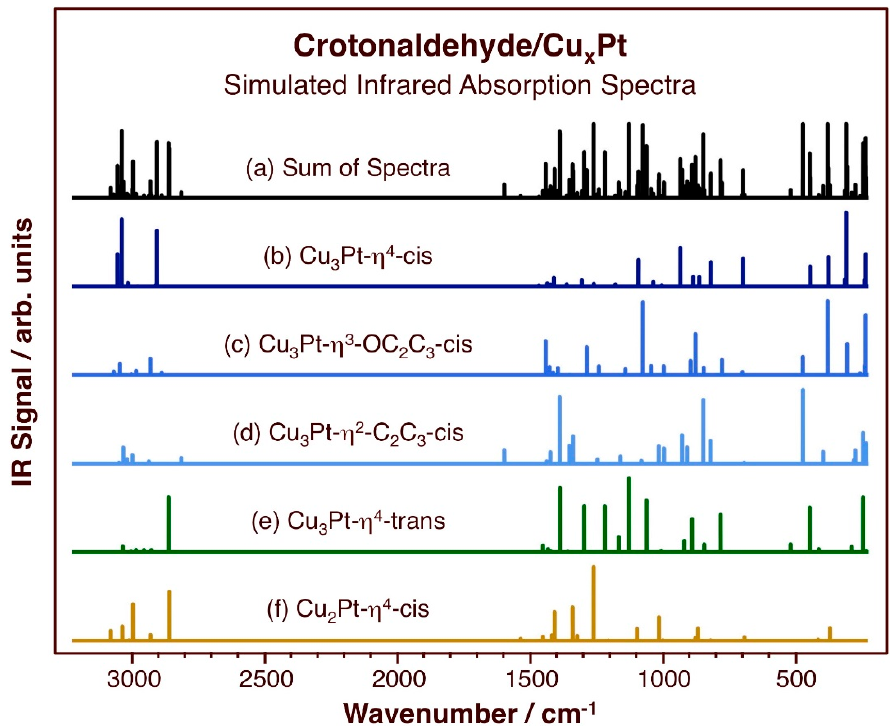
Figure 5. Calculated vibrational spectra of crotonaldehyde adsorbed on the indicated surfaces and configurations, namely, on (from top to bottom): (b) Cu 3 Pt- η 4 -cis, (c) Cu 3 Pt- η 3 -OC 2 C 3 -cis, (d) Cu 3 Pt- η 2 -C 2 C 3 -cis, (e) Cu 3 Pt- η 4 -trans, and (f) Cu 2 Pt- η 4 -cis; these are the most stable adsorption